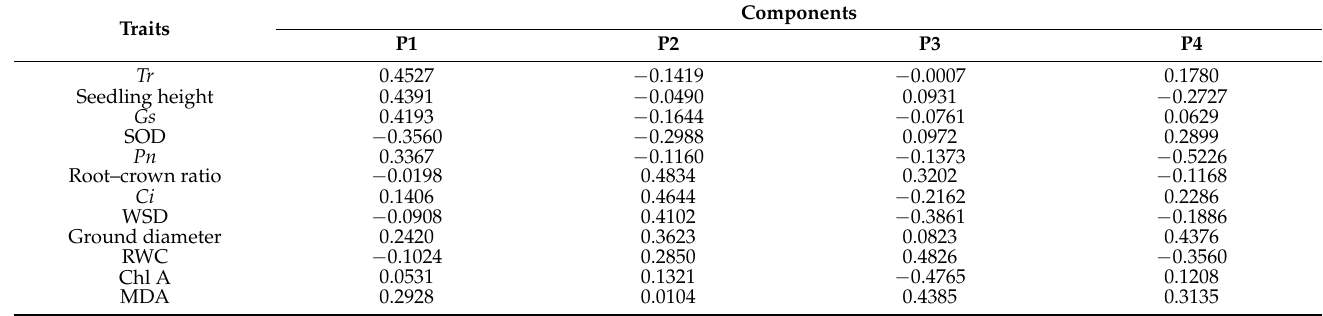
Table A5. The eigenvectors of the principal components under moderate drought stress.